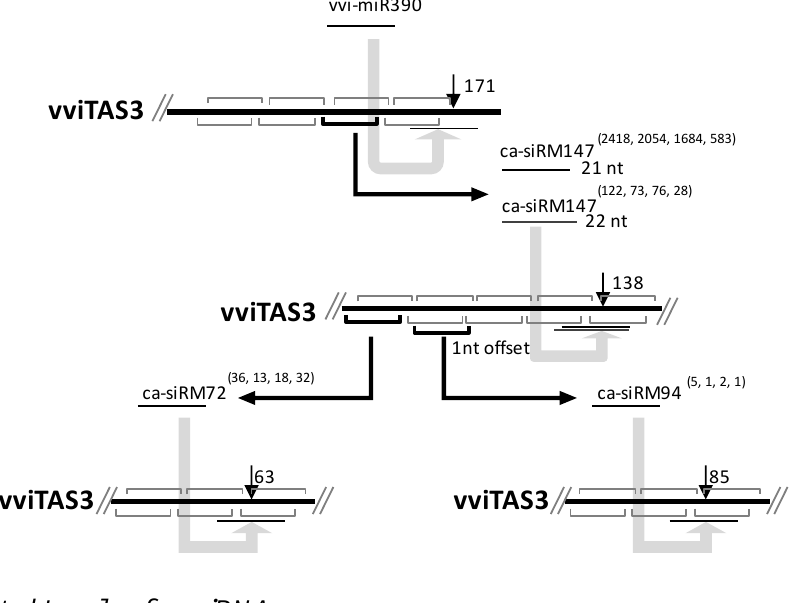
Figure 3. Cleavage cascades generated by cis -cleavages of siRNA on the sense strand of vvi TAS3 . The four numbers in the brackets indicate the raw abundance of ca-siRNA in grapevine berries, leaves, inflorescences, and tendrils,